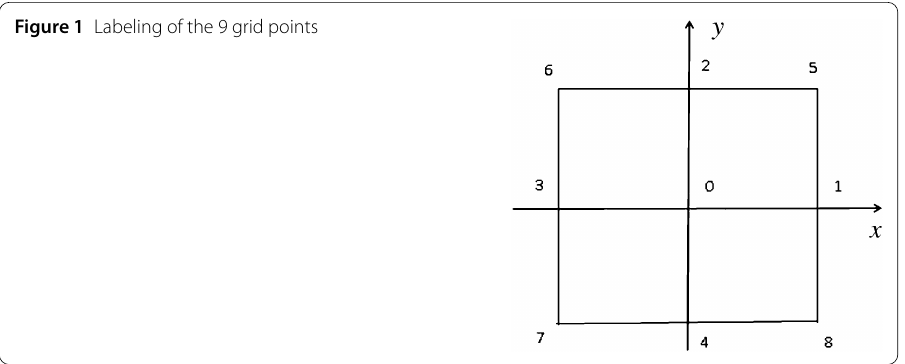
Figure 1 Labeling of the 9 grid